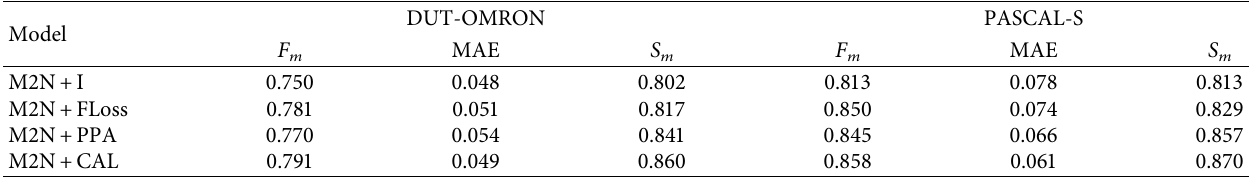
Table 5: Comparison of the proposed loss and three other methods on two challenge datasets. M2N: the proposed M2Net with ResNeXt- based backbone CAL: centerness-aware loss; I: Intersection over Union loss [17, 27]; FLoss: F-measure based loss [28]; PPA: pixel position aware loss